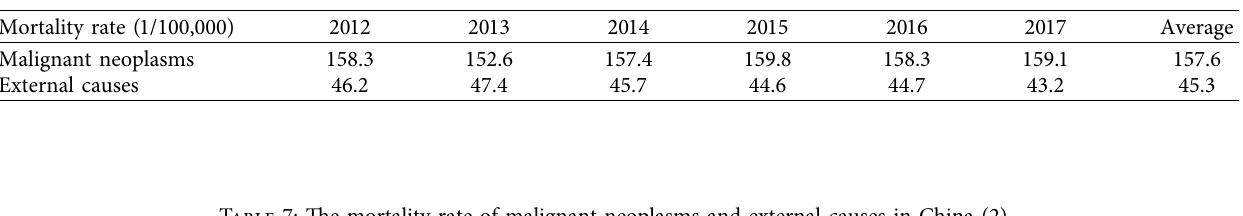
Table 7: The mortality rate of malignant neoplasms and external causes in China (2). Mortality rate (1/100,000) 2000 Average Malignant neoplasms 167.9 External causes